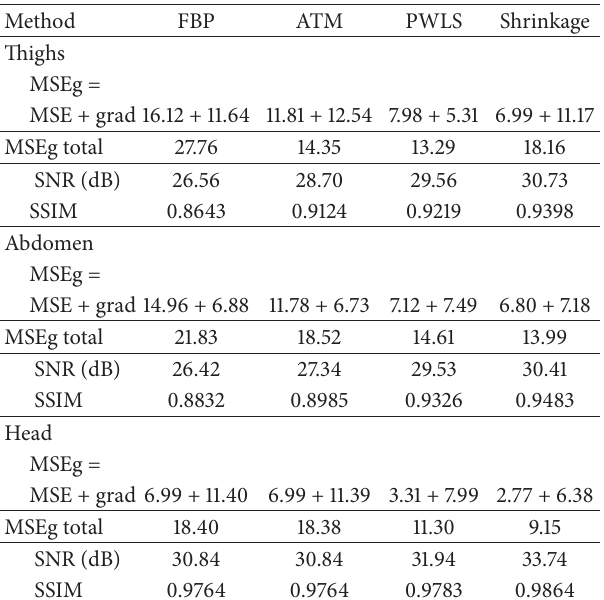
Table 1: Quantitative measures for the compared algorithms.